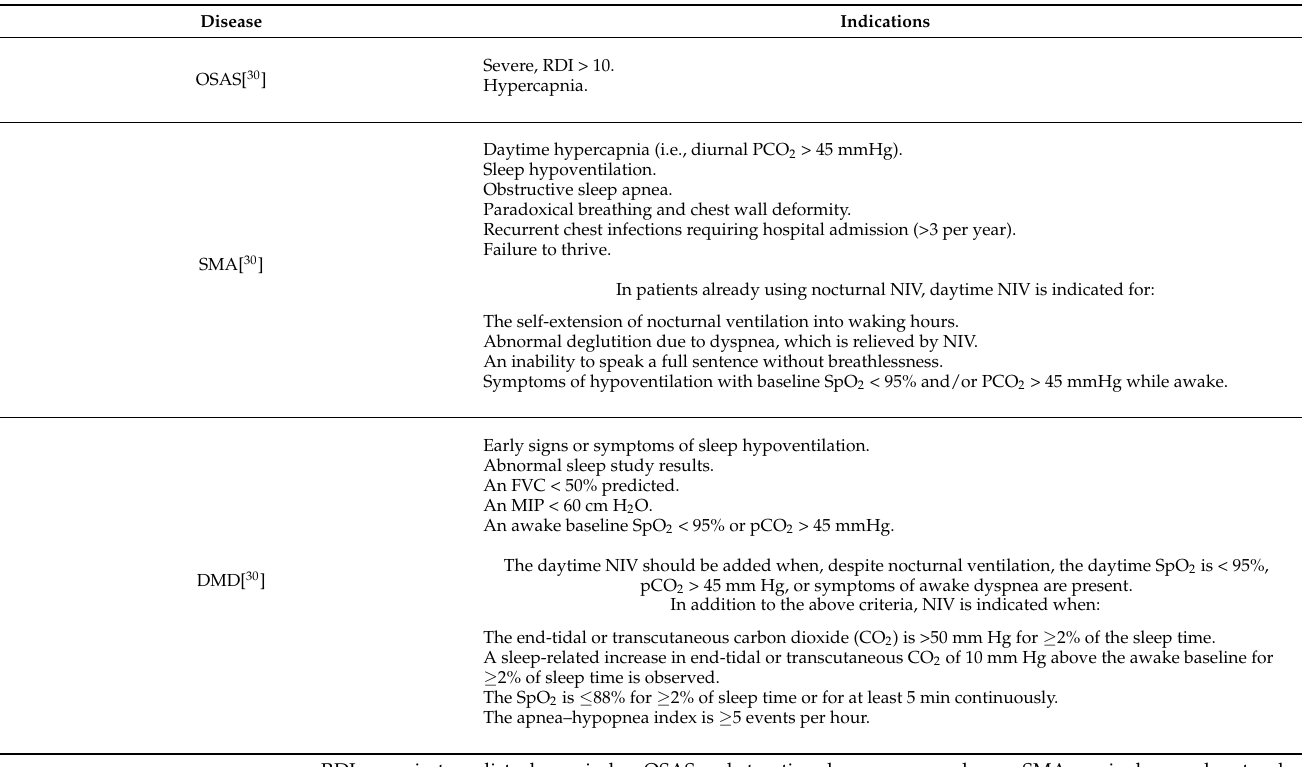
Table 3. Indications for long-term non-invasive ventilation initiation in obstructive sleep apnea syndrome, spinal muscular atrophy and Duchenne muscular